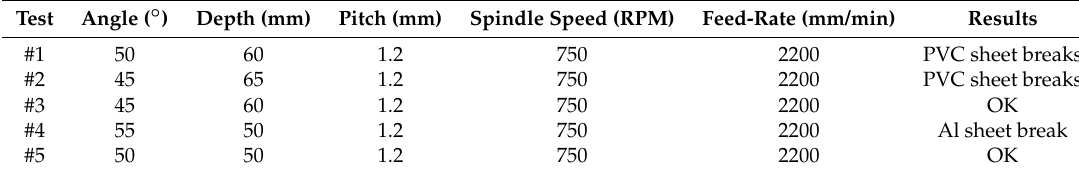
Table 3. Results of preliminary tests.